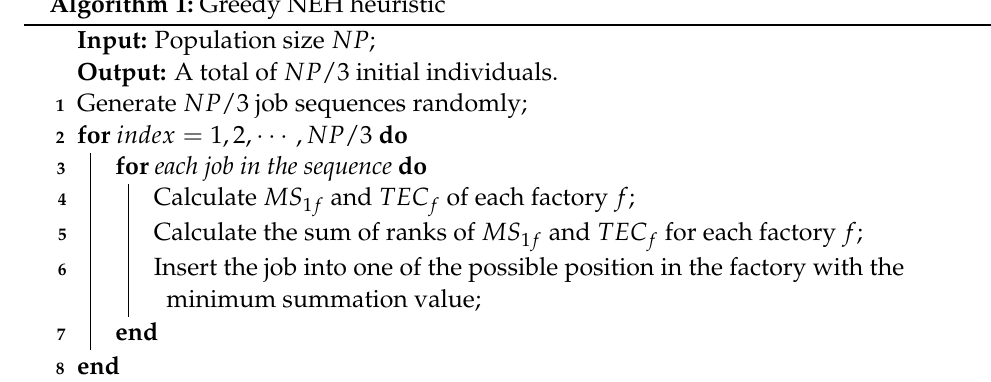
Algorithm 1: Greedy NEH